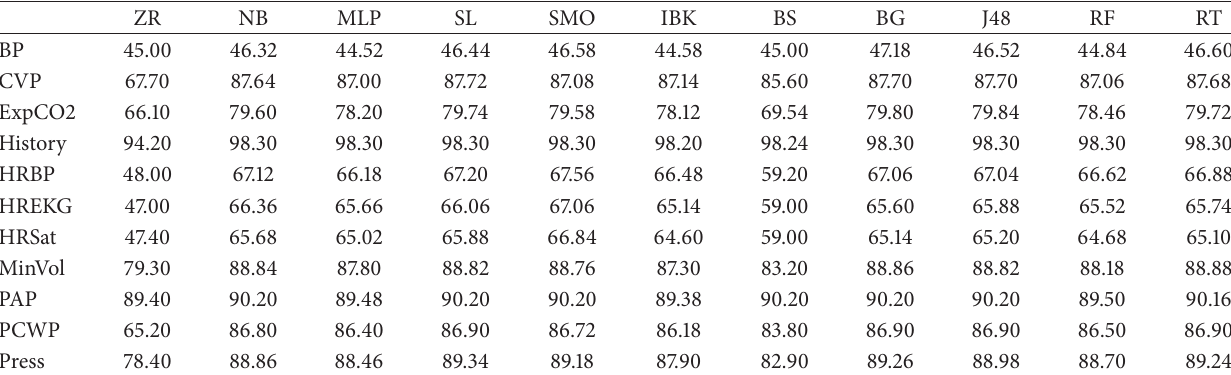
Table 6: Classification accuracies with datasets having 1000 samples